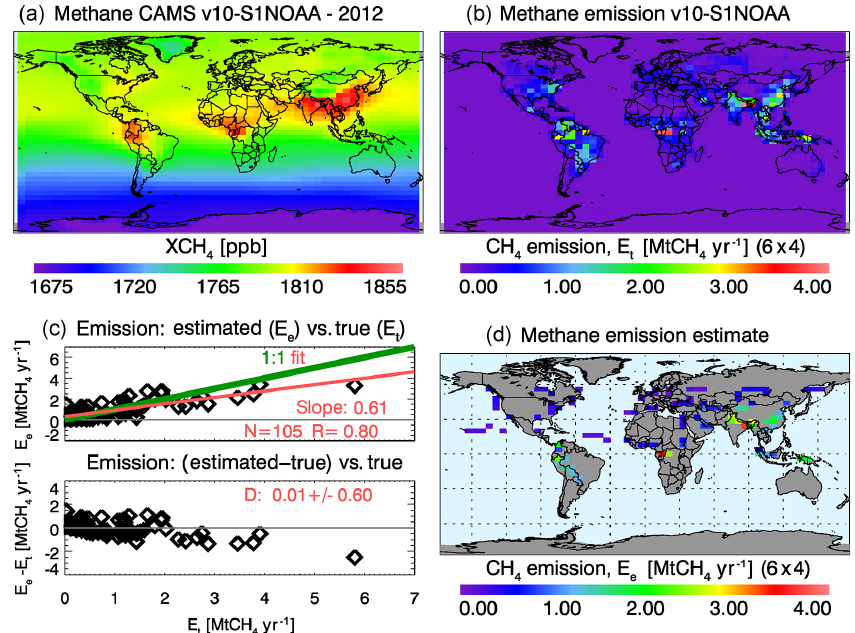
Figure 5. As Fig. 4 but for year